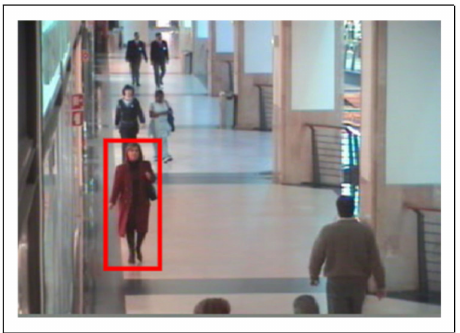
Figure 22. High precision and low recall.